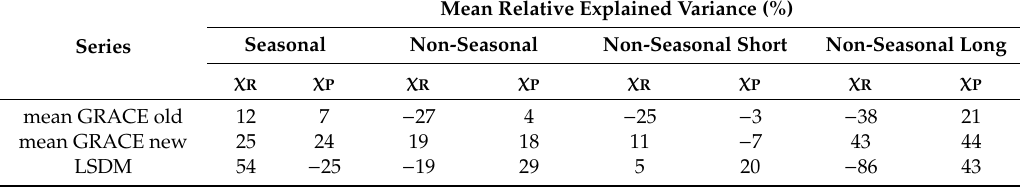
Table 6. Mean values of percentage variances in GAO explained by GRACE-based HAM for each oscillation considered: mean GRACE old (the mean of variances for CSR RL05, JPL RL05, GFZ RL05, CNES / GRGS RL03, and ITSG-Grace2016) and mean GRACE new (the mean of variances for CSR